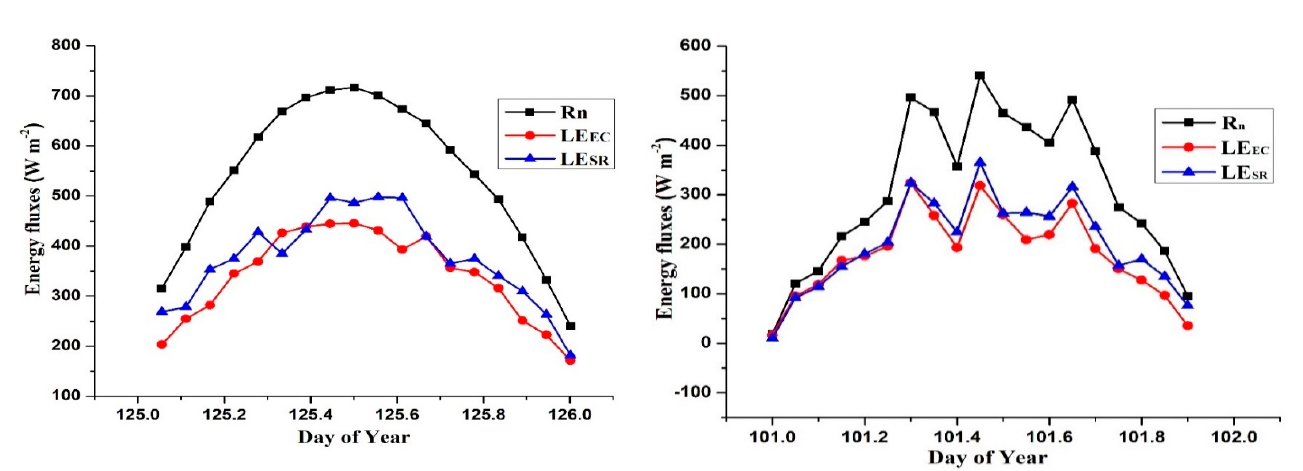
Figure 8. Variation of the R n , LE EC , and LE SR.